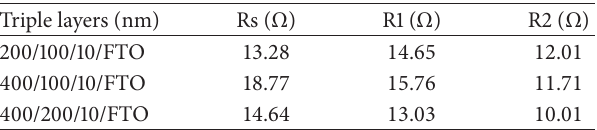
Figure 11: The photocurrent-voltage curves of DSSCs prepared by triple-layers with different particle sizes and the mixing of particle size in TiO 2 layers. Table 6: The parameters of charge transfer resistance in triple-layer structures by EIS measurements.